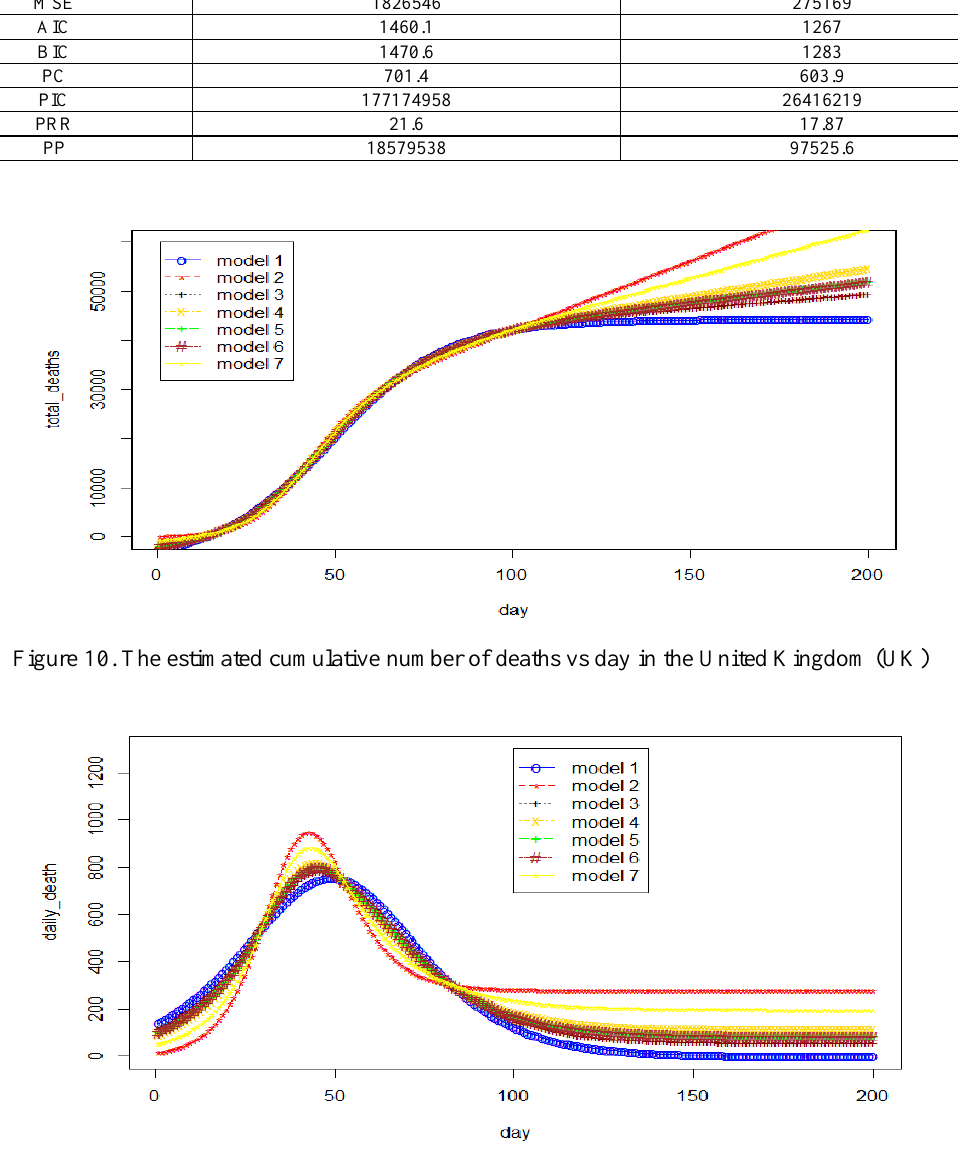
Figure 11: The estimated daily number of deaths vs day in the United Kingdom